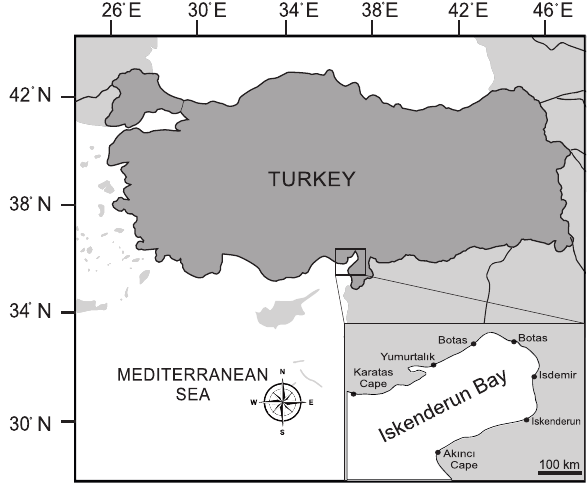
Fig. 1. The sampling area of Mustelus mustelus in the Gulf of Iskenderun, north-eastern Mediterranean Sea